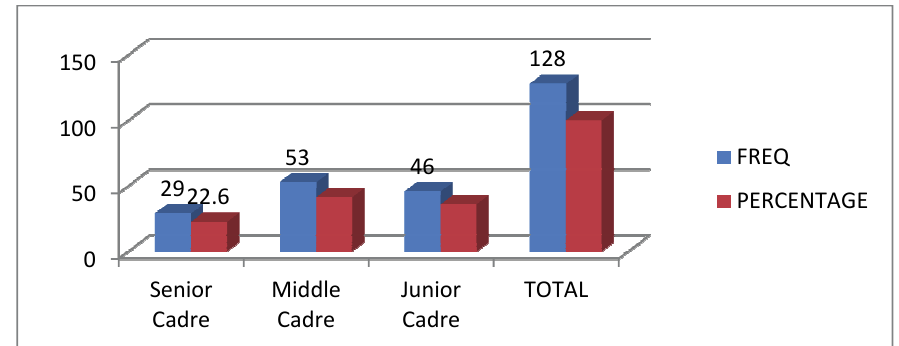
Figure 3 Bar Chart of Official Status of Respondents